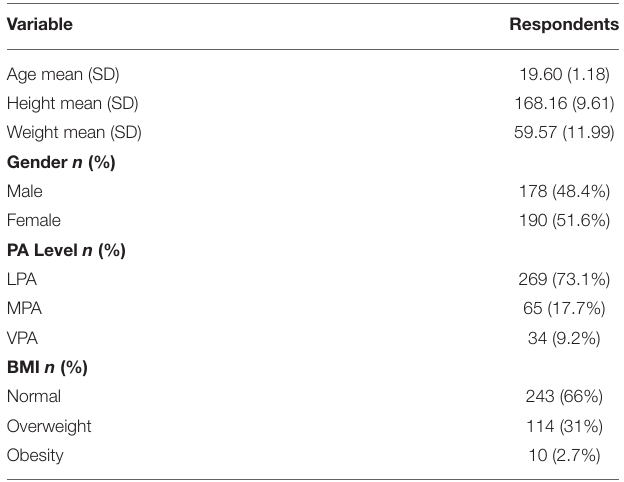
TABLE 1 | General demographic characteristics of the